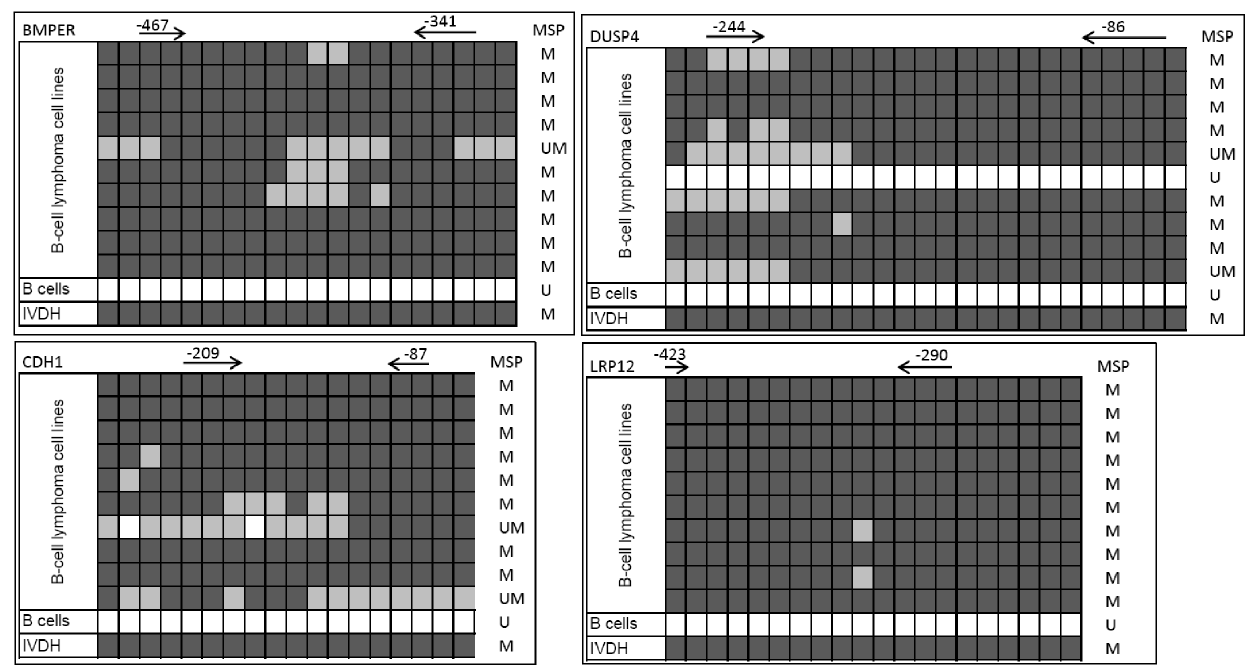
Figure 1. Bisulfite sequencing of individual CpG sites in the promoter regions of BMPER,CDH1,DUSP4 and LRP12 . CpG sites are represented by a box, a methylated site is symbolized by a dark grey box, a partially methylated CpG site is colored in gray and a white box represents an unmethylated CpG site. MSP-primer binding sites are indicated with an arrow above the CpG site. The distance from transcription start to the first base of the primer is indicated by the number above the arrow.